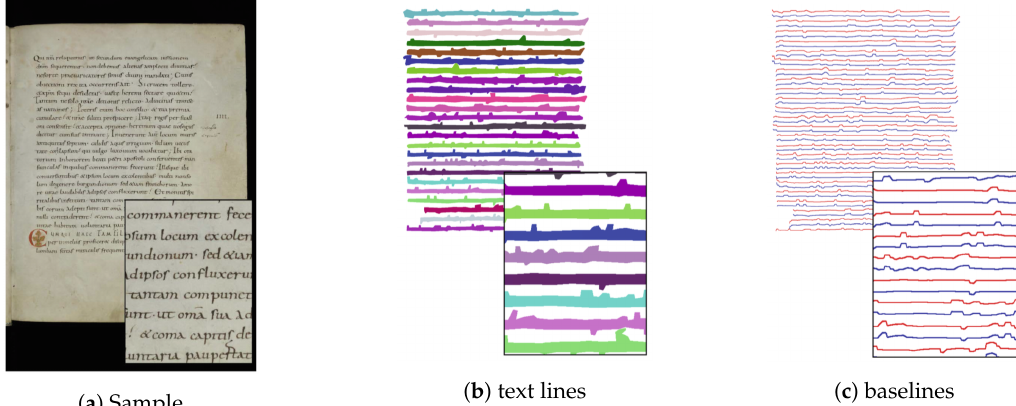
Figure 2. Different approaches for the identification of text lines in the manuscript in ( a ): text line segmentation ( b ) and baseline detection ( c )